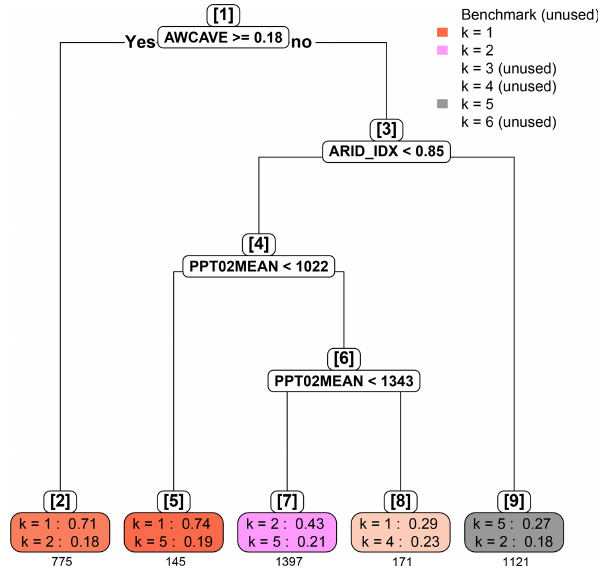
Figure 10. Same as Fig. 9, except that here the classification is done using the LPD labels. The predictors in the splitting rules are ex- pressed in code names for convenience; please refer to the same reference table in Fig.